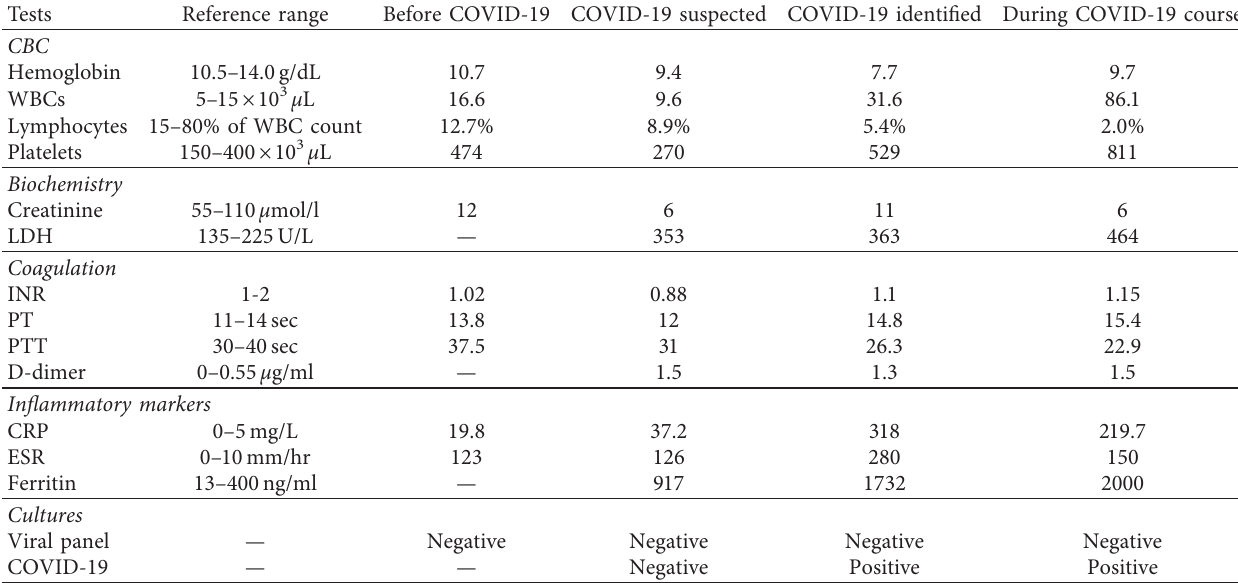
Table 1: Investigations before and during COVID-19 course of illness.